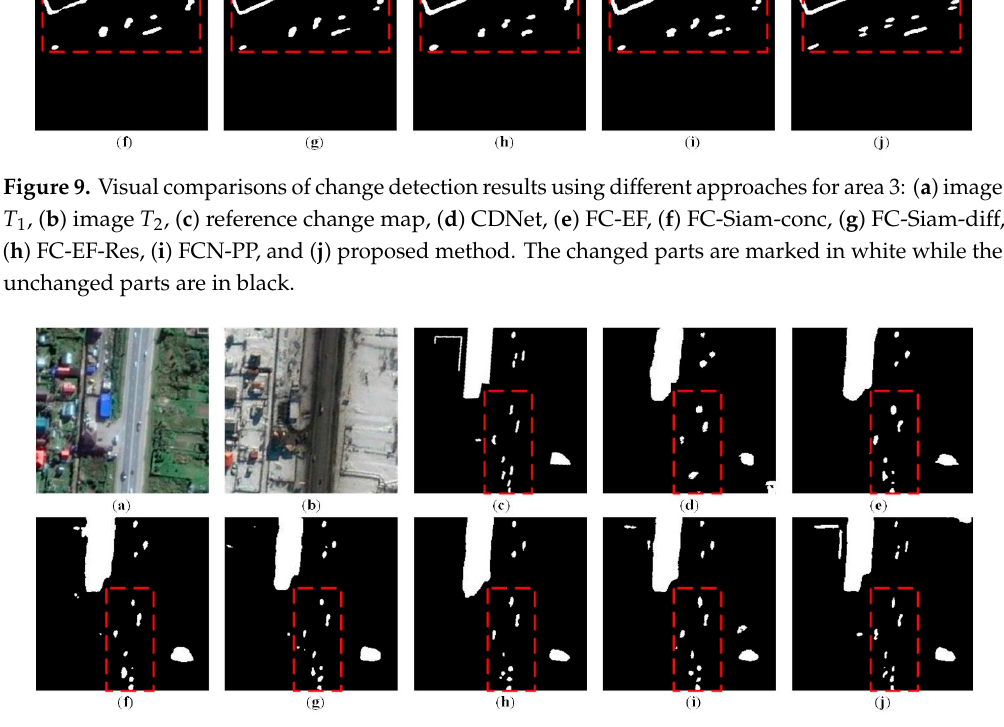
Figure 10. Visual comparisons of change detection results using di ff erent approaches for area 4: ( a ) image T 1 , ( b ) image T 2 , ( c ) reference change map, ( d ) CDNet, ( e ) FC-EF, ( f ) FC-Siam-conc, ( g ) FC-Siam-di ff , ( h ) FC-EF-Res, ( i ) FCN-PP, and ( j ) proposed method. The changed parts are marked in white while the unchanged parts are in black.